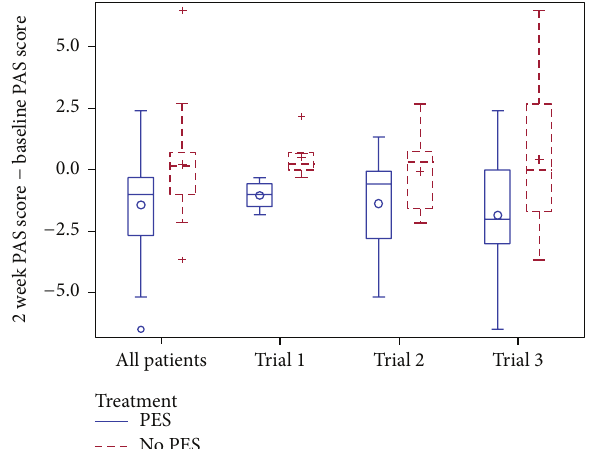
Figure 1: Box and whisker plot of change in penetration aspiration score from baseline to two weeks, by source trial. Comparison of pharyngeal electrical stimulation (PES) versus no PES by multiple linear regression with adjustment, overall mean difference − 0.9 (95% confidence interval − 1.7, − 0.1; 𝑝 = 0.020 ); no difference between trials ( 𝑝 = 0.89 ).